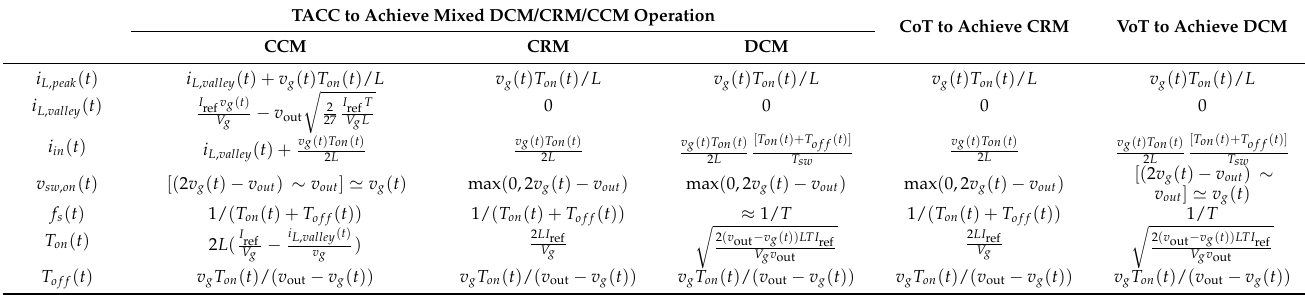
Table A2. Variables with different controls.